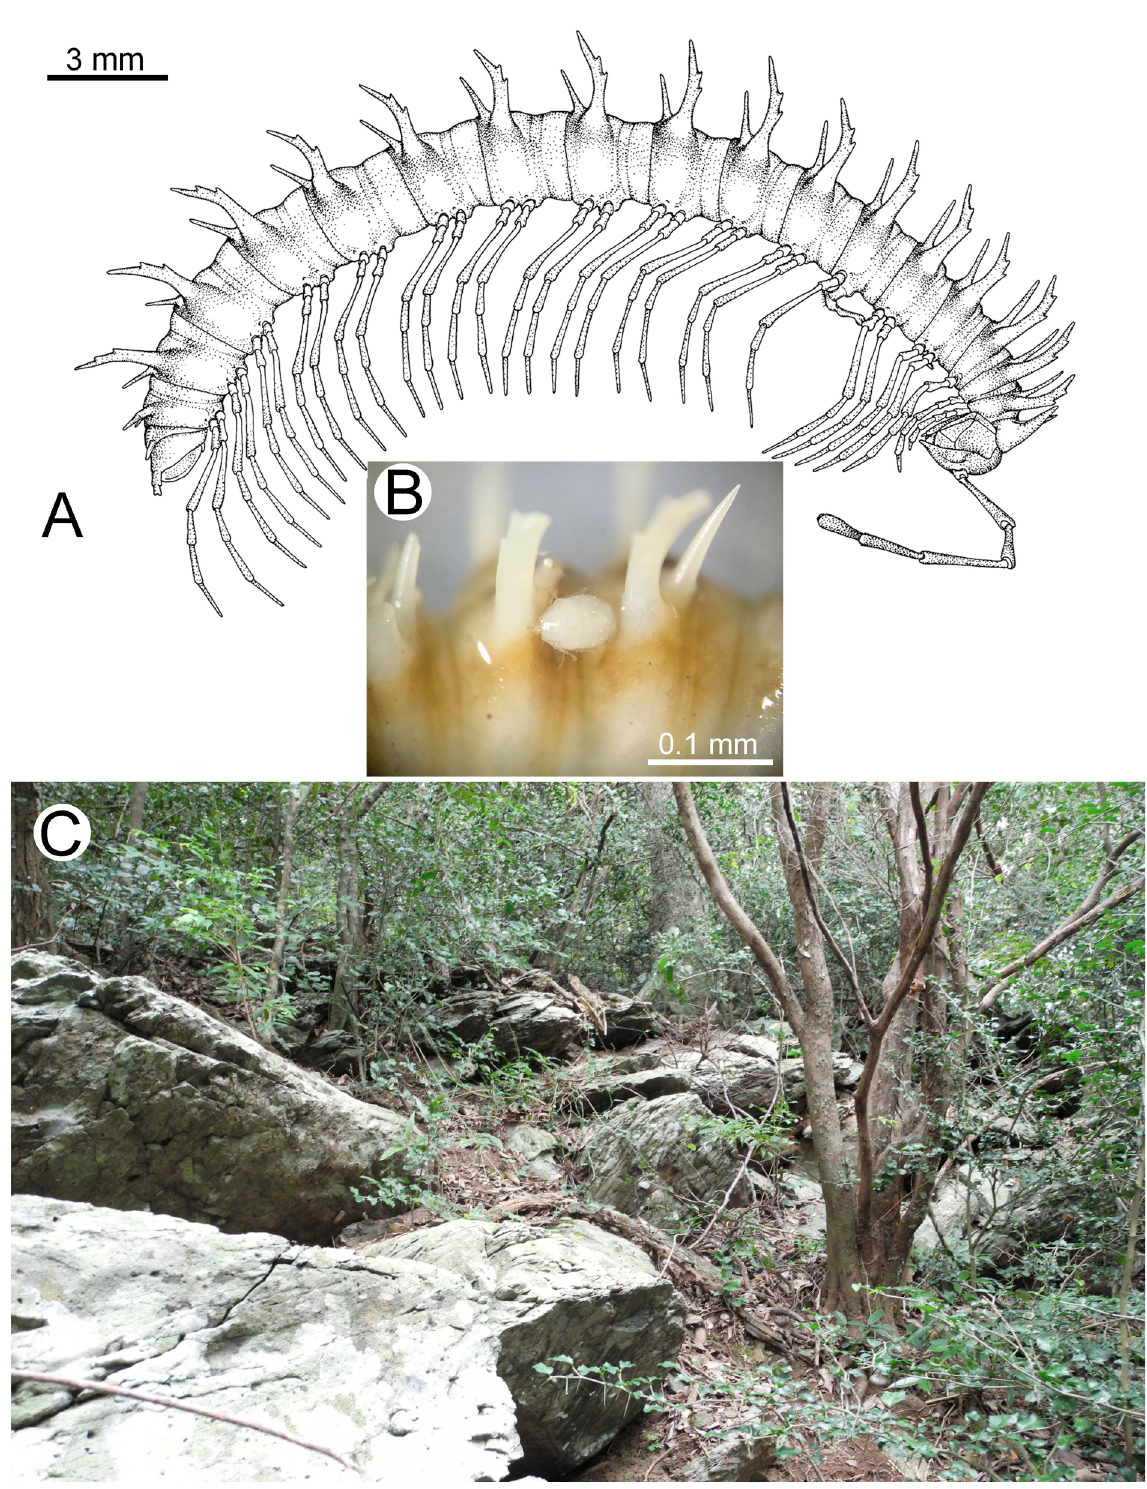
Fig. 6. Nagaxytes acantherpestes (Golovatch & Enghoff, 1994) gen. et comb. nov. A . Drawing of ♂, holotype ( ZMUC 000101457). B . Parasitic mite. C .